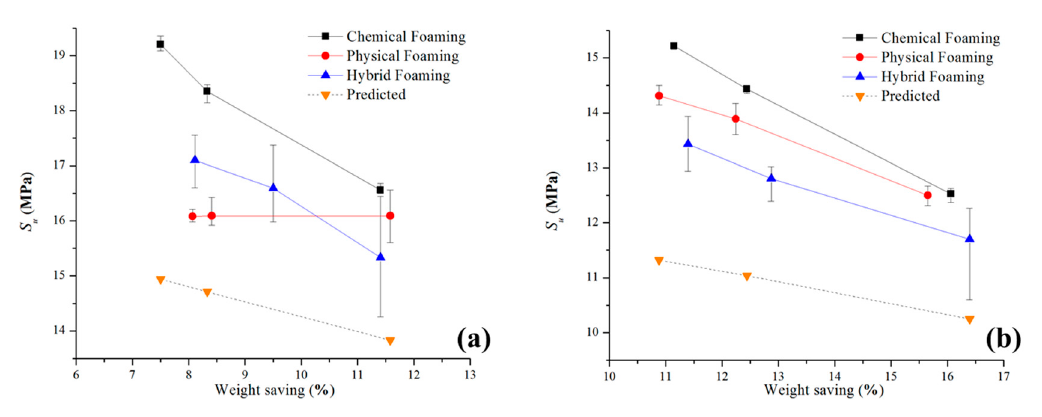
Figure 8. Ultimate Tensile Stress (S u ) against weight-saving ( a ) unfilled PP ( b ) talc-filled PP.